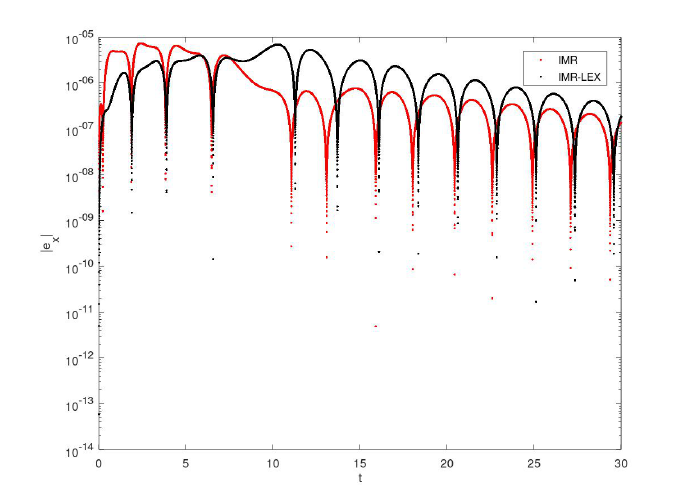
Figure 1. Errors of IMR-LEX (black) compared to errors of IMR (red) for generic initial conditions x 0 = 2.16, p 0 = 4.3.